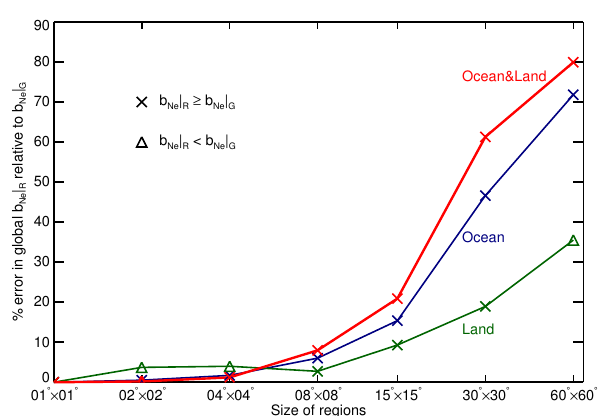
Fig. 7. Same as Fig. 6, but for sensitivity of r e to τ a